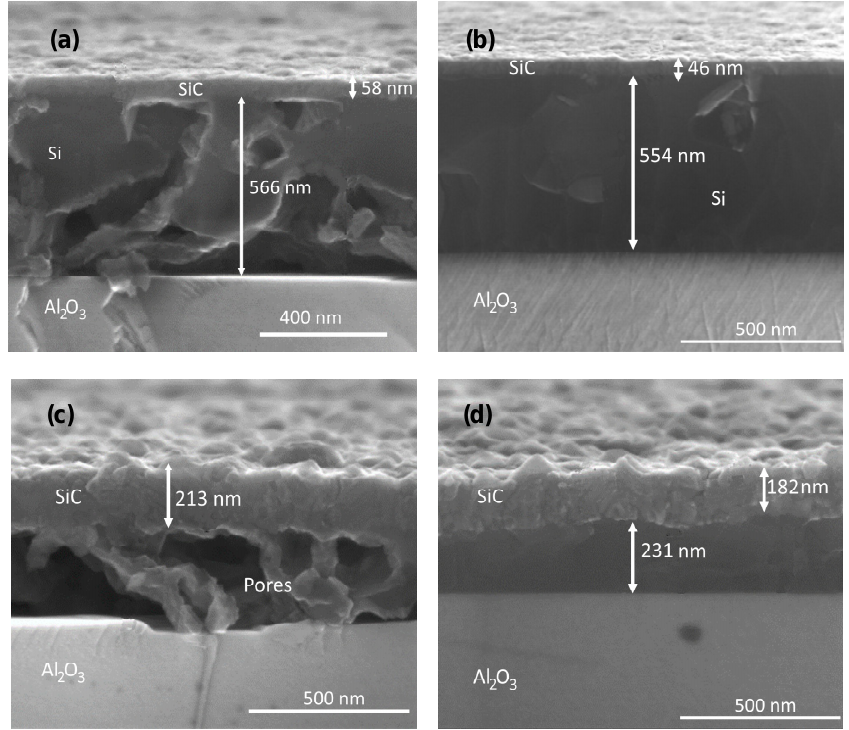
Fig. 4. SEM images of the cross-sections of different areas of the SiC/Si (100) and SiC/Si (111) samples grown on Al O ; (a) cross-section of a region containing pores, coated with a SiC layer in the SiC/Si (100)/ 2 3 r-plane (1 1 20) Al O structure, grown on Fab-2-R-plane sapphire; (b) cross-section of an area practically 2 3 free from pores in the SiC/Si (100)/r-plane (1 1 20)Al cross-section of a region containing pores, coated with a SiC layer on the SiC/Si(111)/c-plane Al ture; (d) cross-section of an area practically free from pores on the SiC/Si(111)/c-plane Al